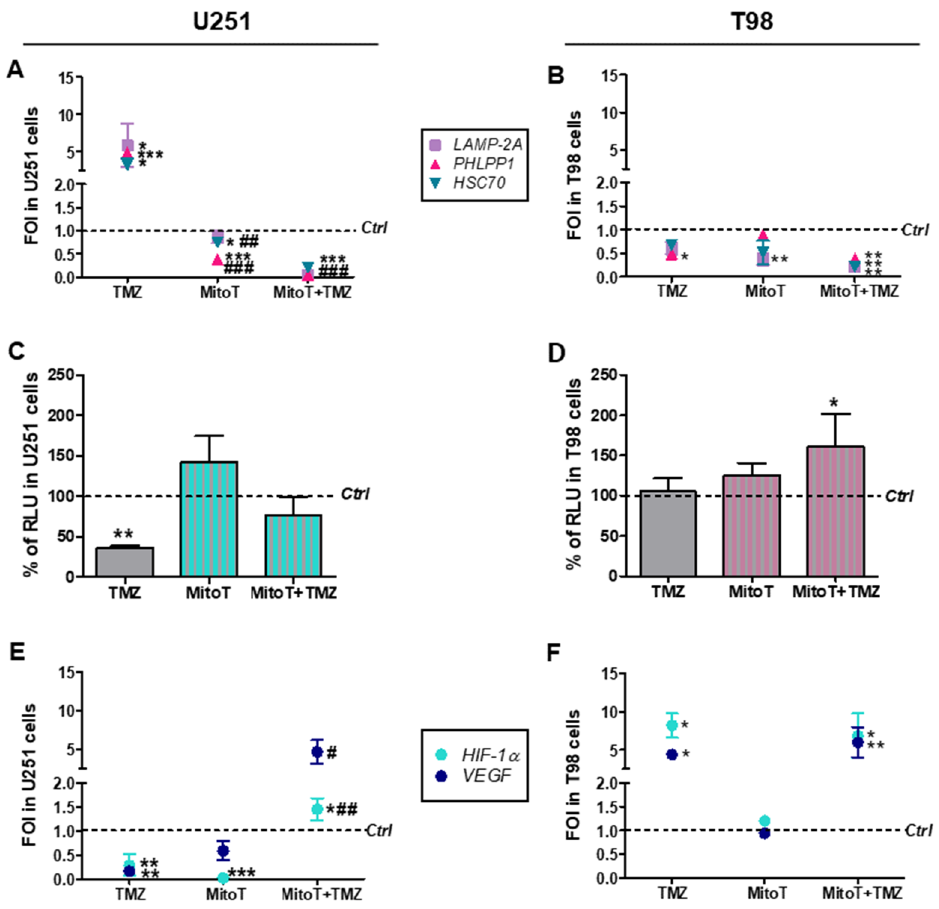
Figure 2. Involvement of chaperone-mediated-autophagy (CMA) after Temozolomide and MitoTempo (MitoT) treatment. ( A ) Gene expression analysis for CMA-related genes ( LAMP2A , HSC70 , PHLPP1 ) analyzed by means of Real-time PCR in U251 and ( B ) T98 cells after treatment with 100 μM Temozolomide (TMZ) ± 25 μM MitoT. Data were normalized for β-ACTIN , and the ΔΔCt values were expressed as FOI of the ratio between treated and control cells. * p < 0.05; ** p < 0.01; *** p < 0.001 treated vs. control cells. # p < 0.05, ## p < 0.01, ### p < 0.001 vs. TMZ-treated cells. ( C ) Biochemical assay for HIF-1α activity in U251 and ( D ) T98 cell lines. Data were expressed as RLU, obtained normalizing luciferase counts for the amount of proteins quantified by Bradford assay. ** p < 0.01 vs. control cells. ( E ) Gene expression analysis for HIF-1α and vascular endothelial growth factor ( VEGF ) expression in U251 and ( F ) T98 cells. * p < 0.05; ** p < 0.01 vs. control cells; # p < 0.05, ## p < 0.01 vs. TMZ-treated cells. Mean values ± SD of three independent experiments.